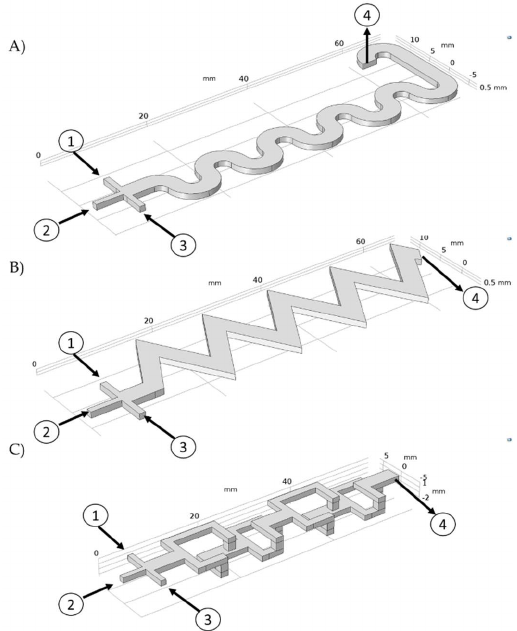
Figure 1. Microfluidic mixer geometries as shown in the Comsol graphics interface. ( A ) Serpentine−based mixer (SB), ( B ) Triangular−based mixer (TB), ( C ) 3D−based mixer (3DB). (1–3. Inflow for FeCl 2 and FeCl 3 , 2. Inflow for NaOH, and 4. Outflow).